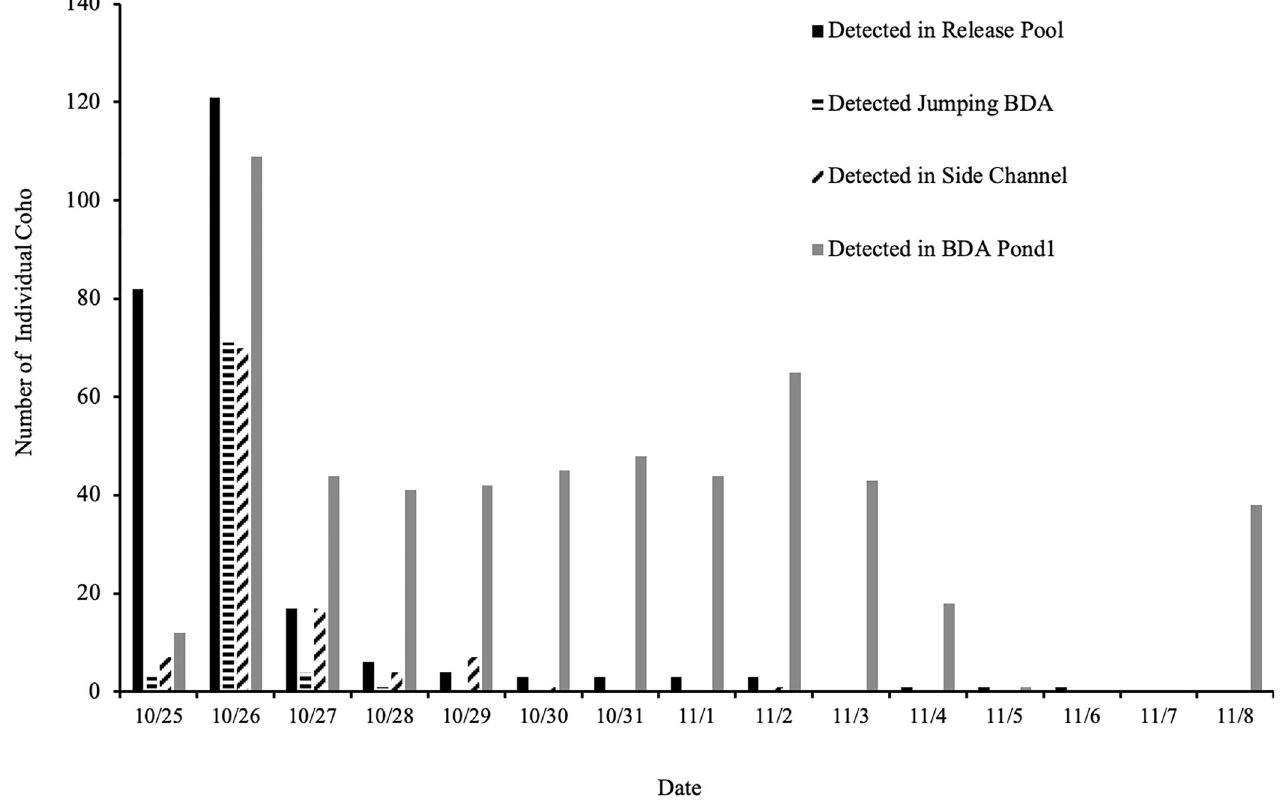
Fig 7. Daily PIT antenna detections of juvenile coho salmon above and below BDAs in 2017. Daily detections in 2017 of the number of individual juvenile coho salmon in the release pool, jumping a BDA, using a side channel passage and in BDA Pond 1, and above BDAs 1 and 2 (coho n = 139 of the 155 released). No individuals were detected below the block net on the downstream end of the release